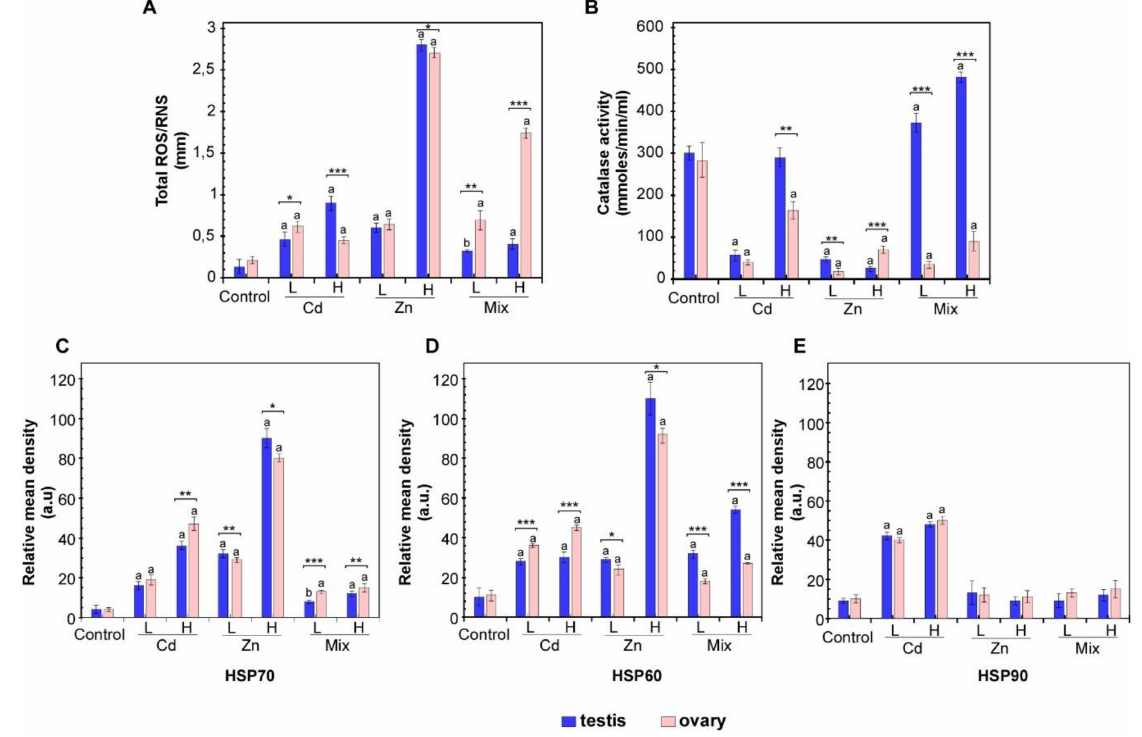
Figure 1. Redox response system of P. lividus reproductive tissues (testis and ovary) after exposures to high (H), low (L) doses of Cd, Zn or a mix of both metals, as reported in Table 1. ( A ) Total ROS amount; ( B ) catalase activity; ( C ) relative HSP70 protein amount; ( D ) relative HSP60 protein amount; ( E ) relative HSP90 protein amount. Bars represent the mean values from the three different experiments ± SD. Statistical significance among testis and ovary results is shown as asterisks (*: p < 0.05; **: p < 0.01; ***: p < 0.001). Letters denote statistical significance of treated specimens vs. controls (b: p < 0.01; a: p < 0.001).